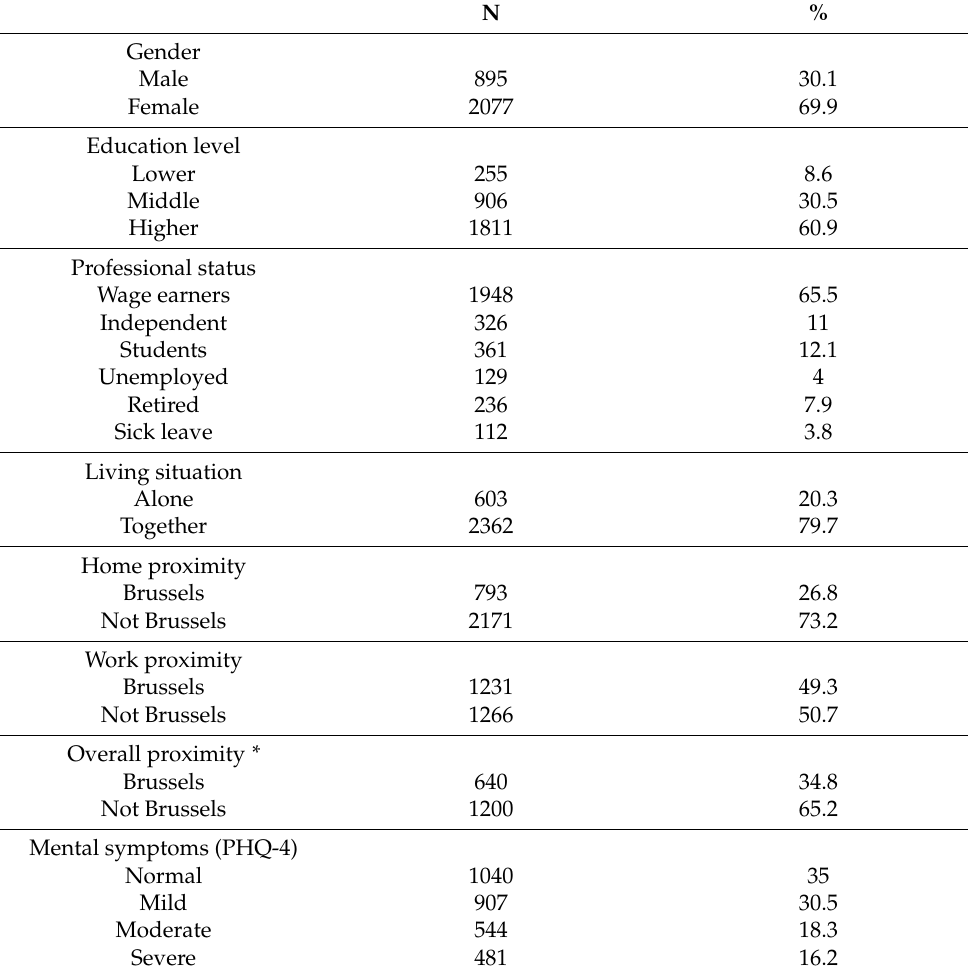
Table 1. Characteristics